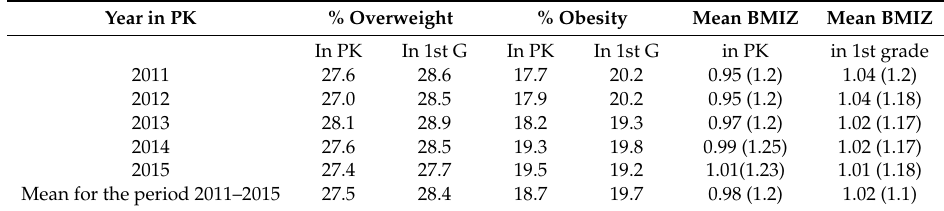
Table 3. Prevalence of overweight and obesity in girls in prekindergarten and in 1st grade.